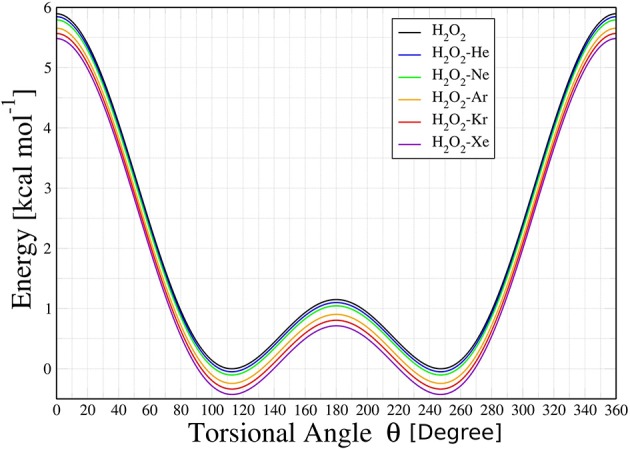
Potential energy curves for H2O2 and H2O2-Ng (Ng = He, Ne, Ar, Kr, and Xe) complexes as a function of torsional angle θ (in degrees).